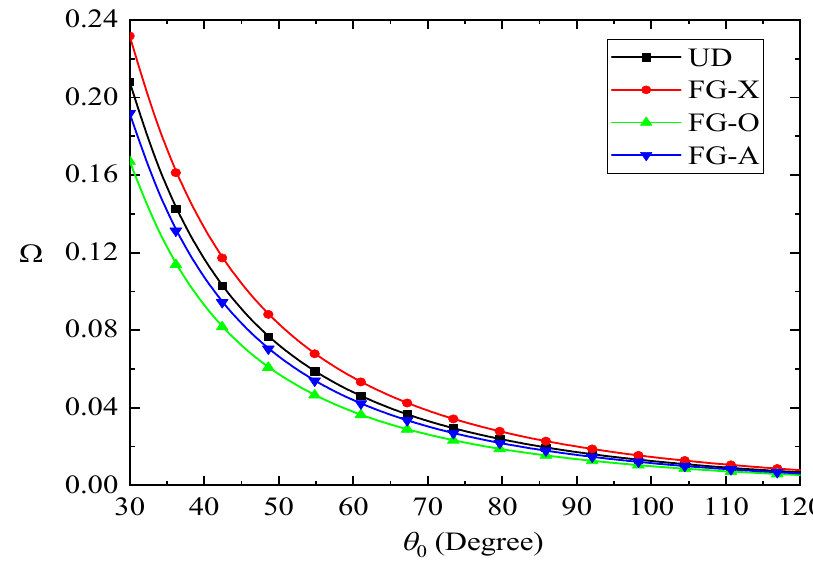
Figure 8. The fundamental frequency of S-S FG-GPLRC moderately thick circular arch ( λ = 1/10) against the subtended angle θ 0 .